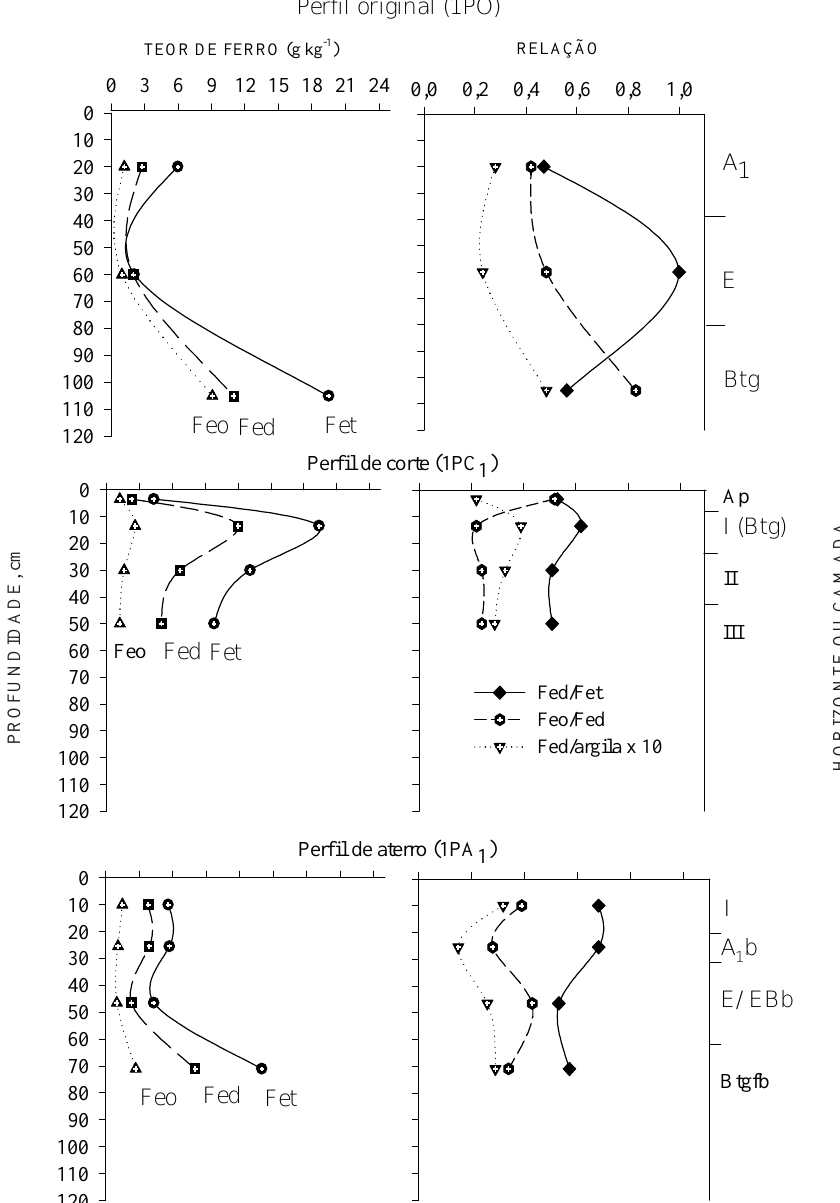
Figura 1. Distribuição dos teores de Fe oxalato (Feo), Fe ditionito (Fed), Fe total (Fet) e as relações Feo/Fed, Fed/Fet e Fed/argila para os perfis: original, de corte e de aterro na área sistematizada há um ano para cultivo de